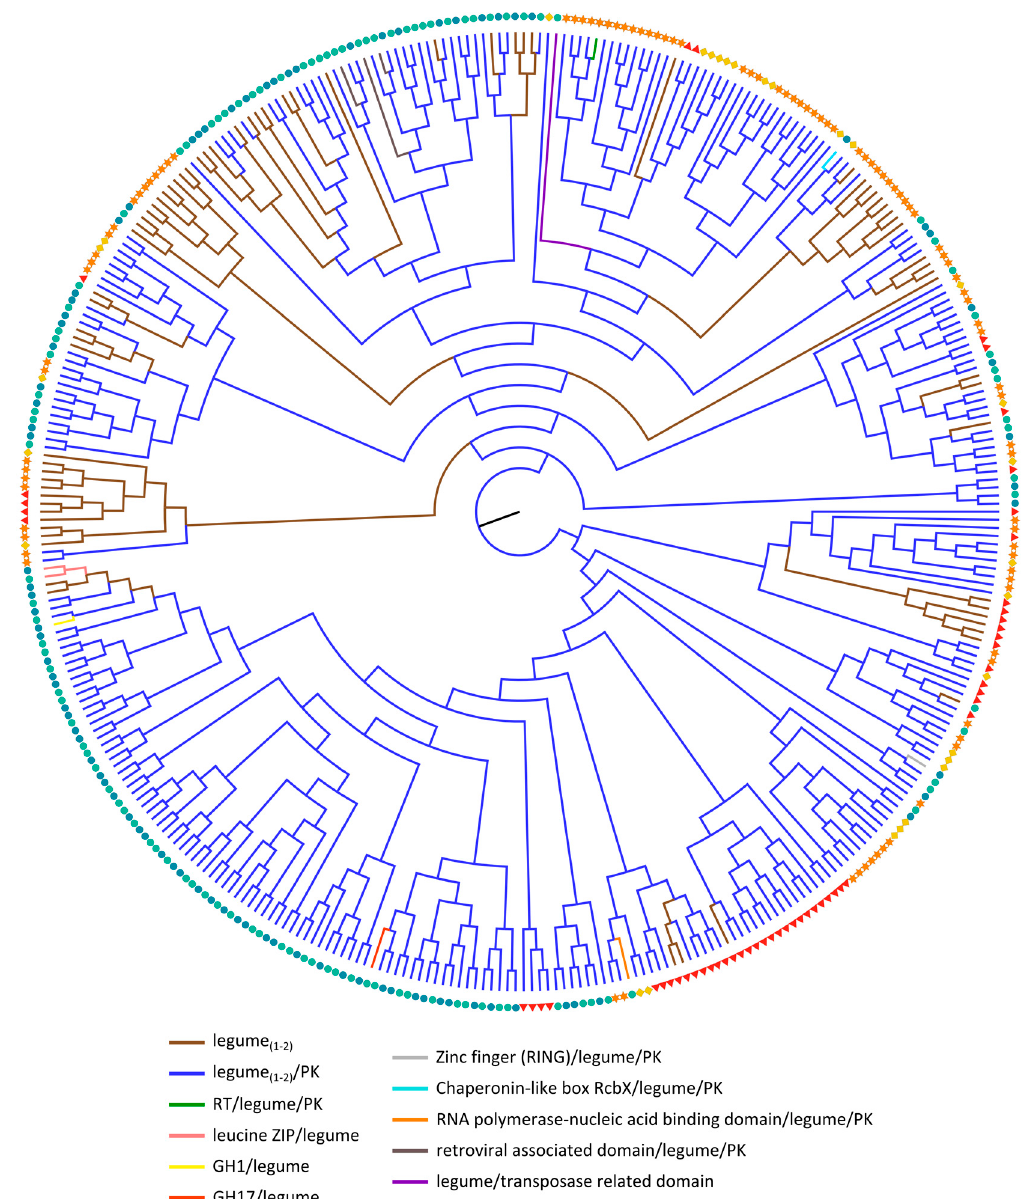
Figure 3. Midpoint rooted cladogram constructed with all legume lectin domain sequences from Arabidopsis (red triangle), soybean (orange star), cucumber (yellow rhomb) and rice ( japonica : green circle, indica : blue circle). The colored branches correspond to the different domain architectures of the full-length legume lectin sequences.